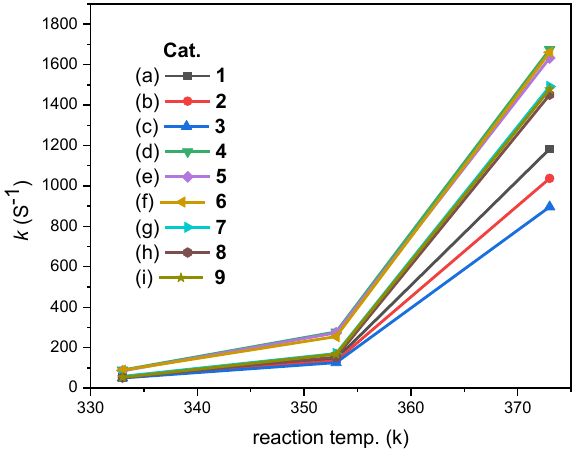
Figure 5. Rate constants of the catalytic oxidation for toluene.